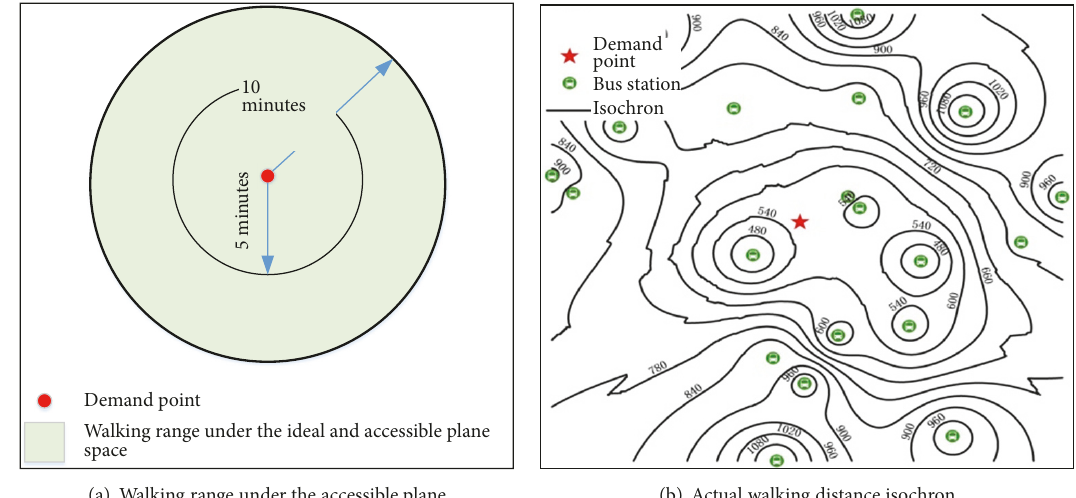
Figure 5: Walking distance